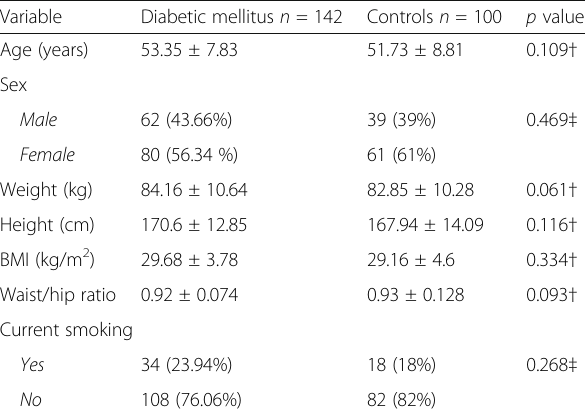
Table 1 Baseline characteristics of the study population